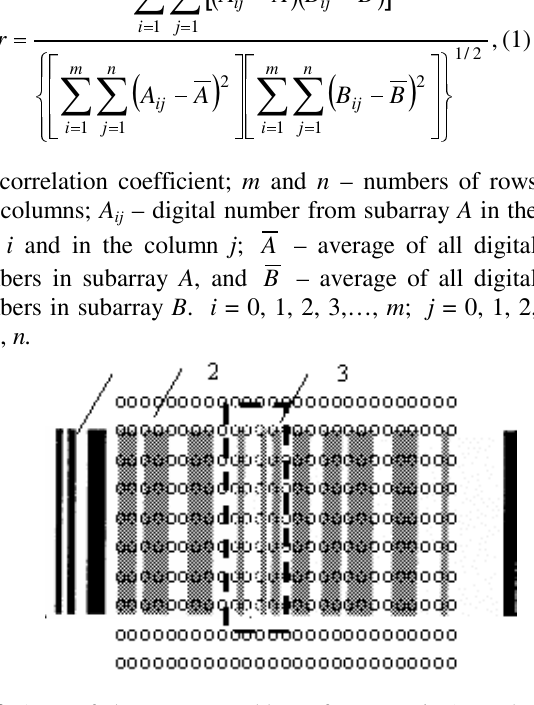
Fig 2. Array of photosensors and bars of meter on it: 1 – coded